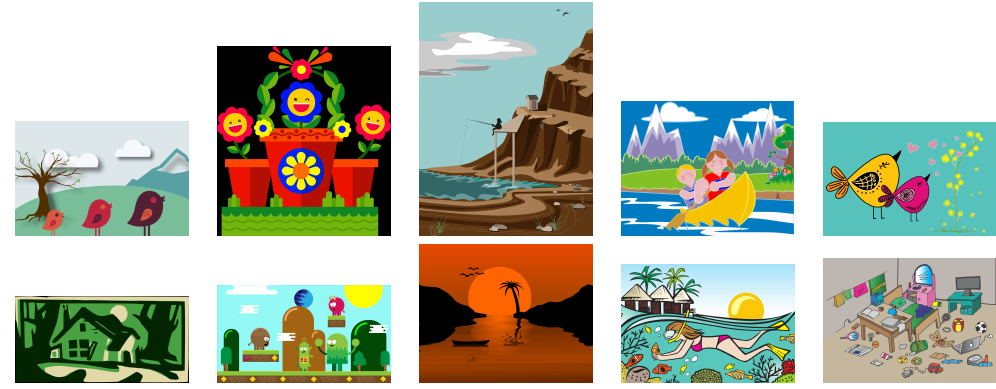
Figure 2. Example scenes from our